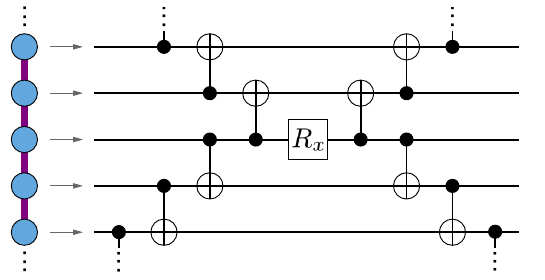
FIG. 8. The circuit diagram for decomposing the operator (μ) associated with a driver line into CNOT - and R x -rotation e − i β ˆ X gates. The filled small circles denote the control